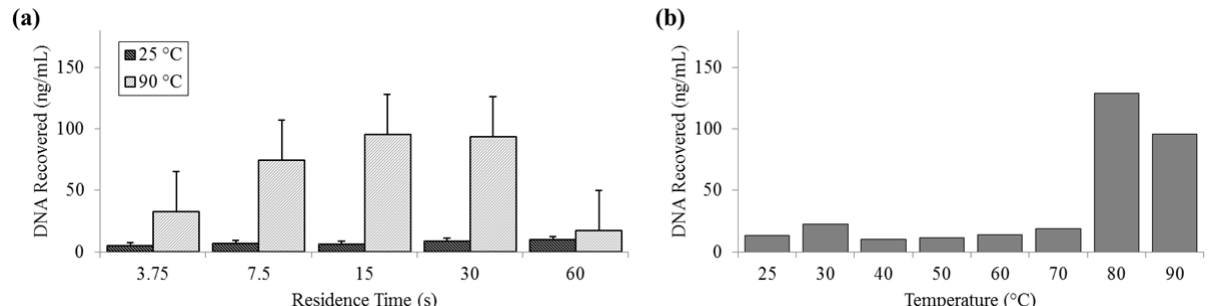
Figure 5. Quantity of DNA recovered as reported by Qubit PicoGreen assay. ( a ) For a range of on-chip residence times from 15 to 60 s at room temperature (25 °C) and maximum heat (90 °C). ( b ) For the full temperature range for 15 s residence time each.